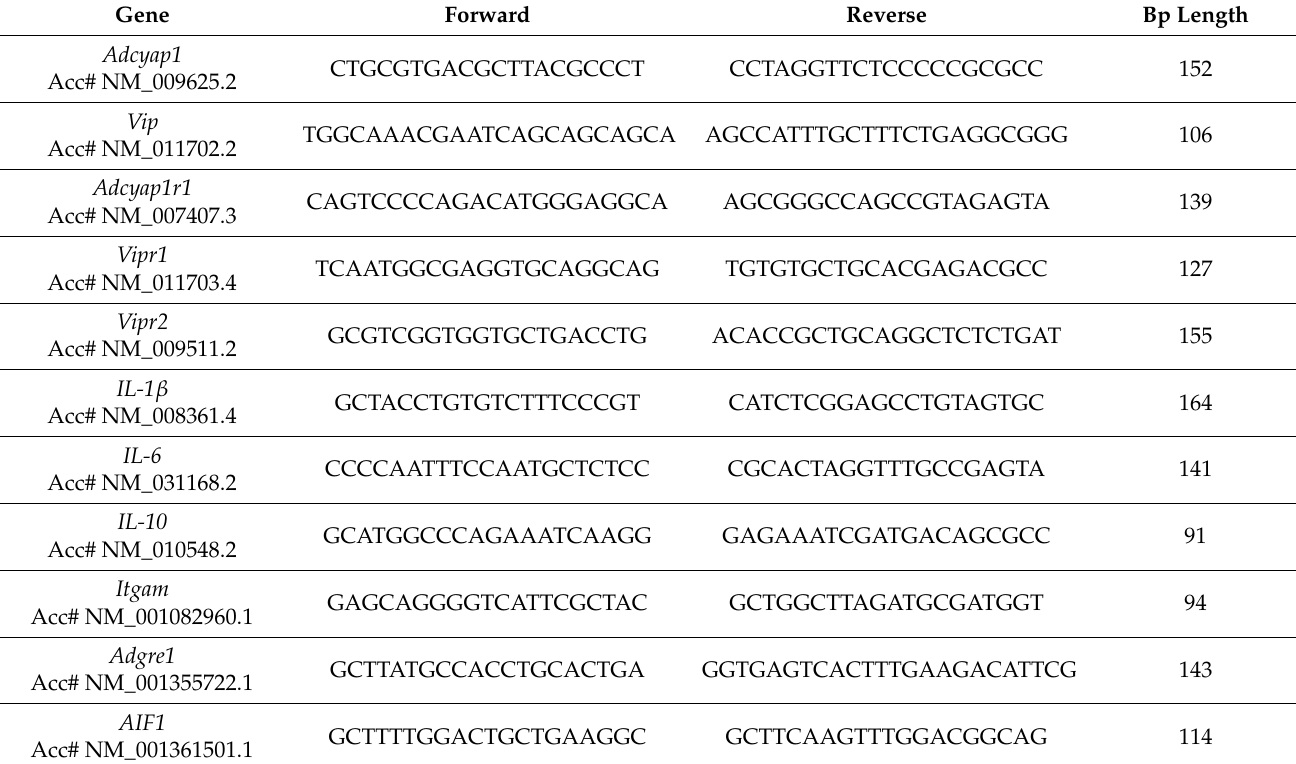
Table 2. Primer sequences used for